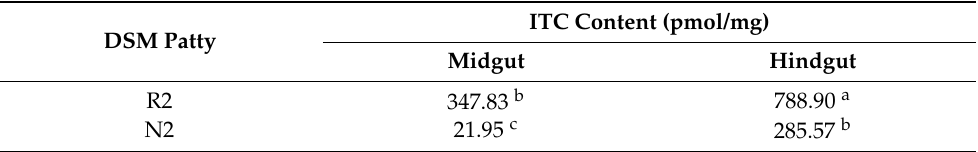
Table 5. Total ITC content of midgut and hindgut tissues of uninfected bees fed on R2 and N2 for 8 days. ITC content is expressed as pmol/mg of gut tissue. Mean values ± standard deviation ( n = 3) are shown. Statistical differences between ITC content means are indicated by different superscript letters ( p < 0.05, LSD test). ITC Content (pmol/mg) DSM Patty Midgut Hindgut